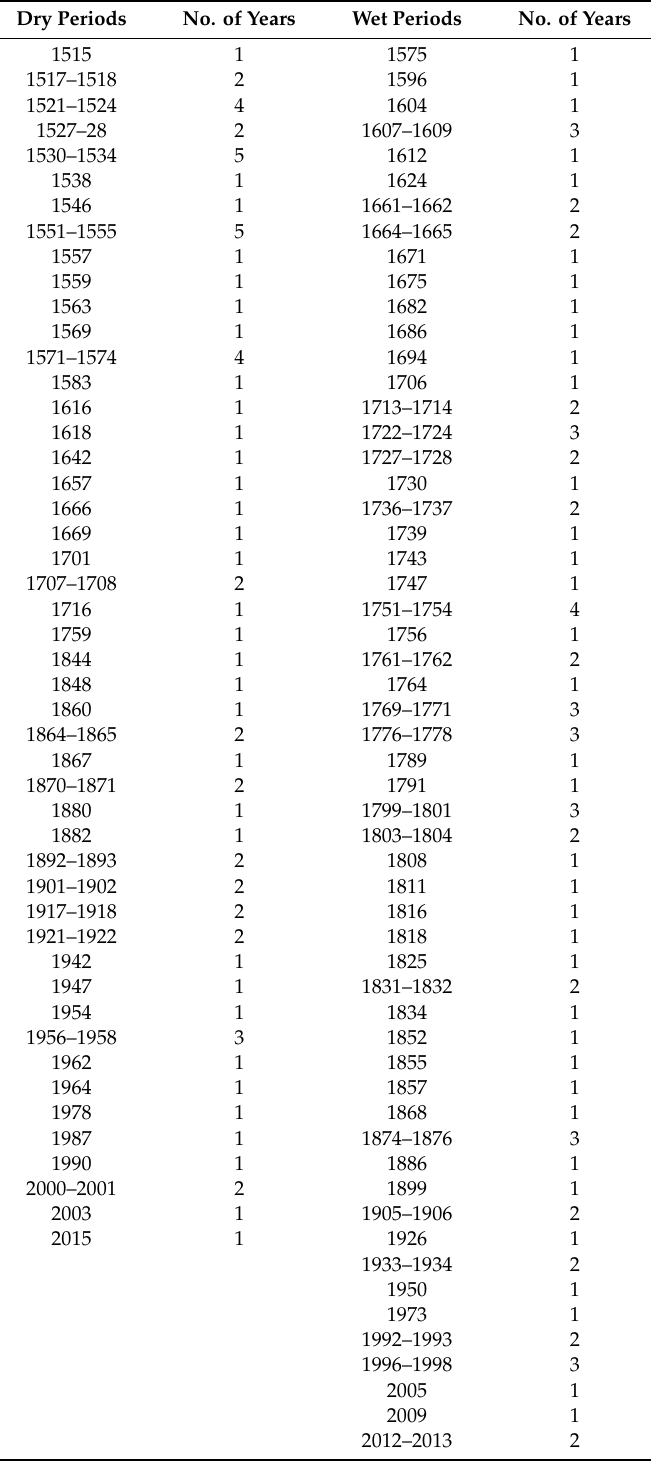
Table A1. Reconstructed dry and wet periods for the southern slope of the Alborz Mountains during the period